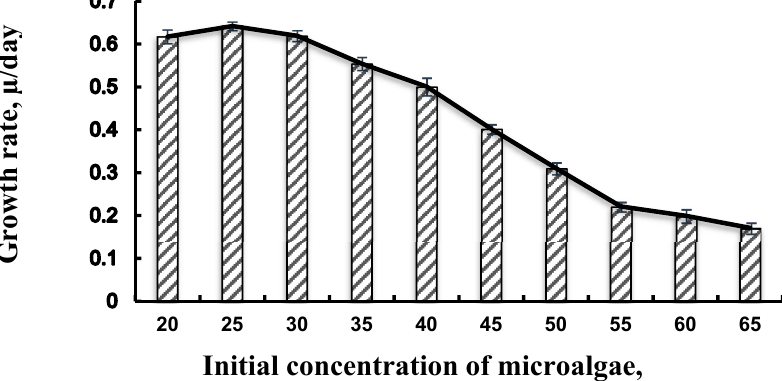
Figure 1. Specific growth rate of Chlorella vulgaris depending on initial biomass concentration.